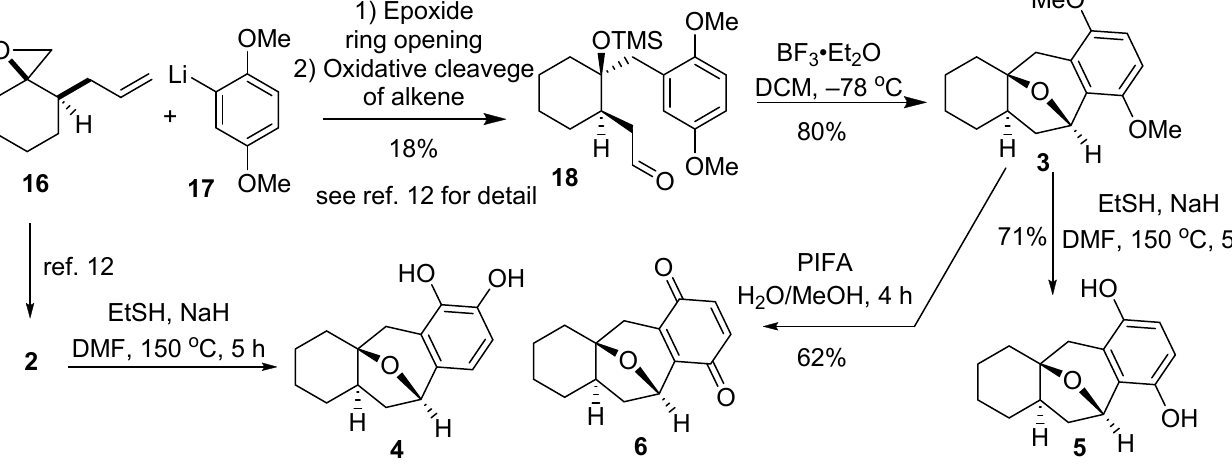
Scheme 1. Synthetic route for the synthesis of brussonol analogs.